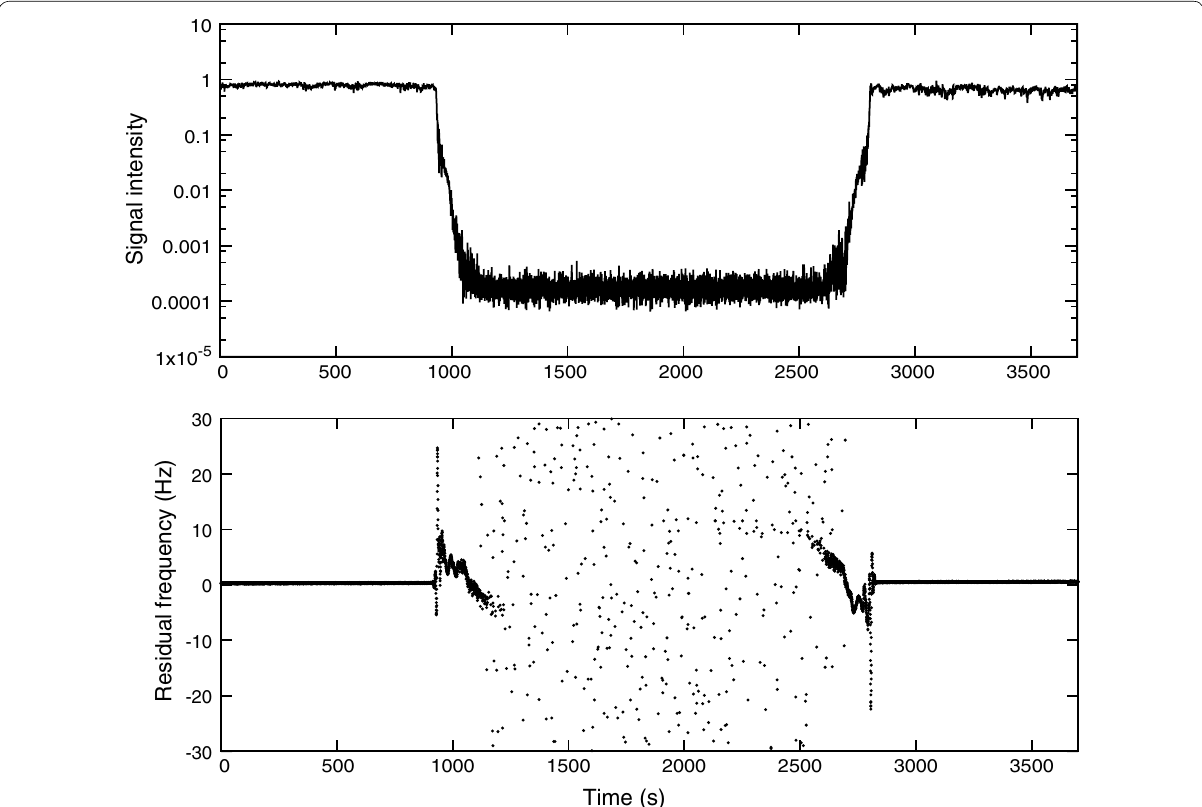
Fig. 4 (Upper) Signal intensity and (lower) residual frequency time series retrieved from the data taken at the ground station (UDSC) on May 6, 2016. The horizontal axis is the elapsed time from the start of the observation. The time interval of the sampling is ~ 0.26